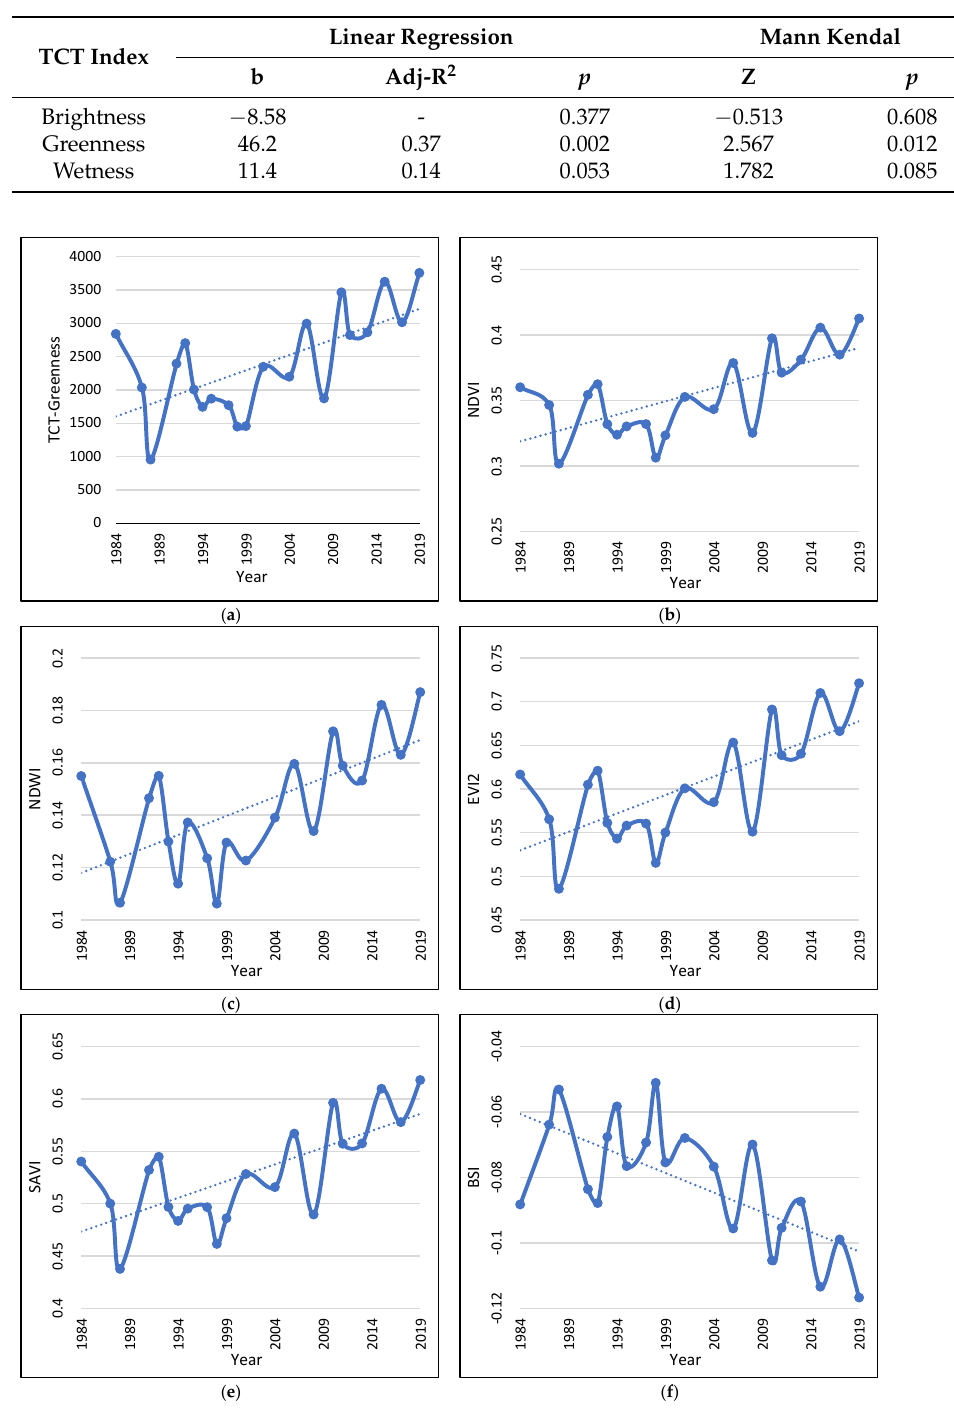
Table 4. Results of the linear regression between time and the TCT indices and Mann–Kendall test.